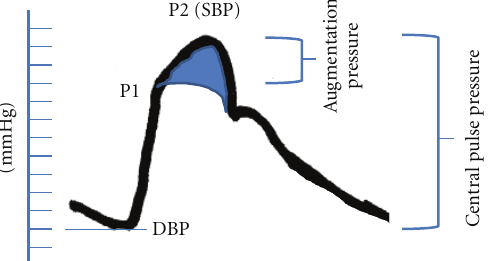
Figure 3: Pictorial representation of central vessel waveform. P1 represents the pressure e ff ected by the forward traveling wave. P2 minus P1 represents the amount of systolic pressure augmentation attributed to the reflected wave. P2 minus the diastolic blood pressure (DBP) is the central pulse pressure. The augmentation pressure (P2-P1) divided by the central pulse pressure is the Augmentation Index. The shaded area in the waveform estimates the e ff ect of the reflected wave form on systolic